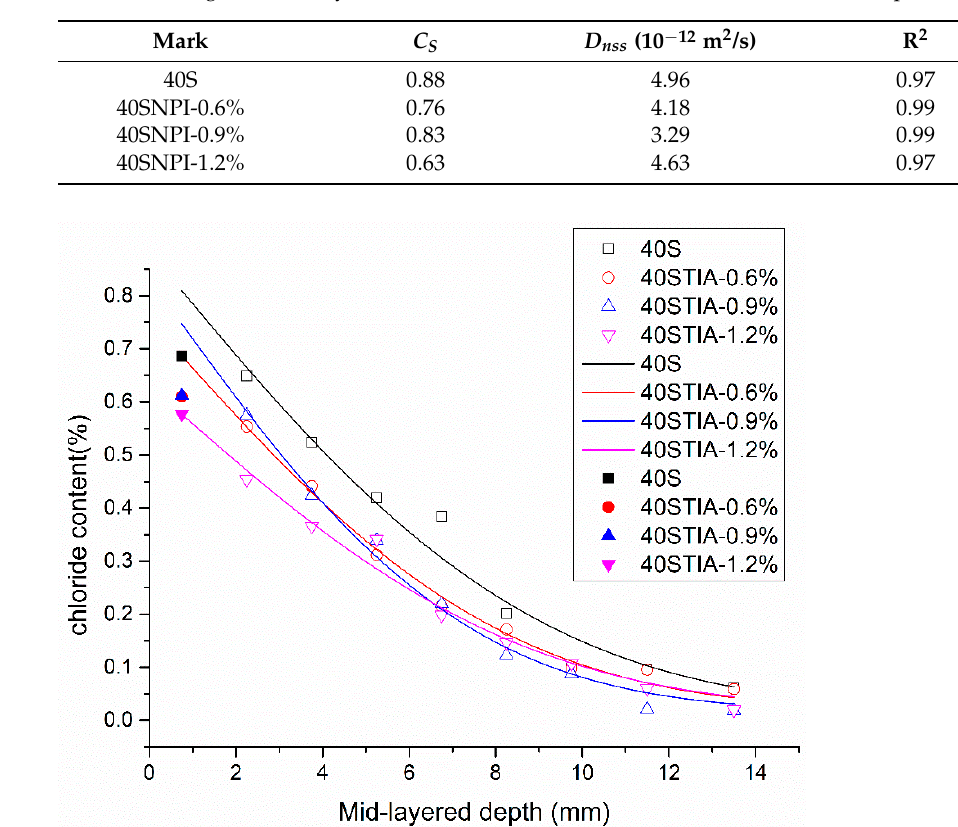
Table 3. The regression analysis results of chloride concentration in the concrete samples.